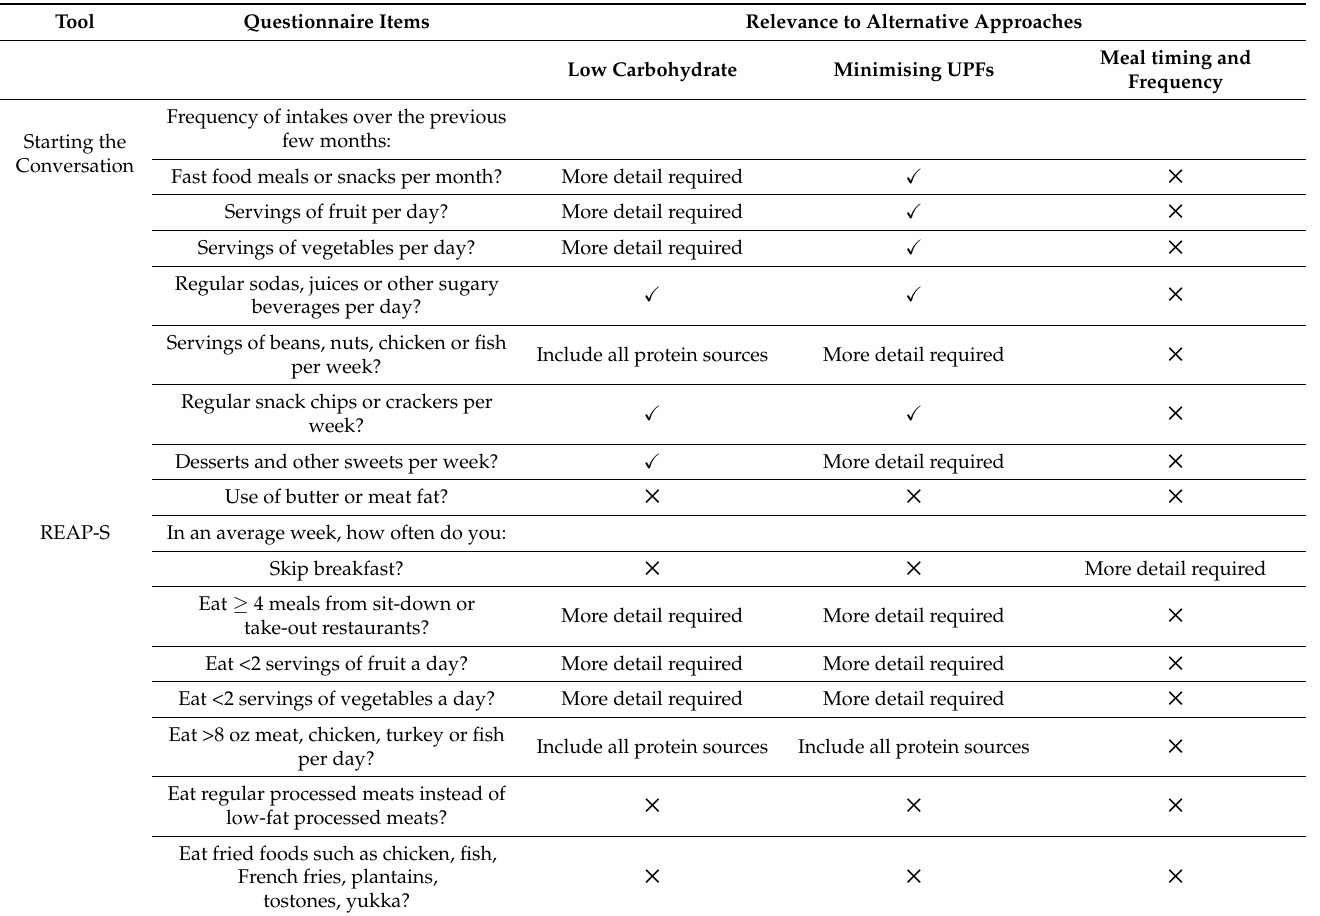
Table 1. Analysis of the relevance of screening tools to more recently proposed dietary